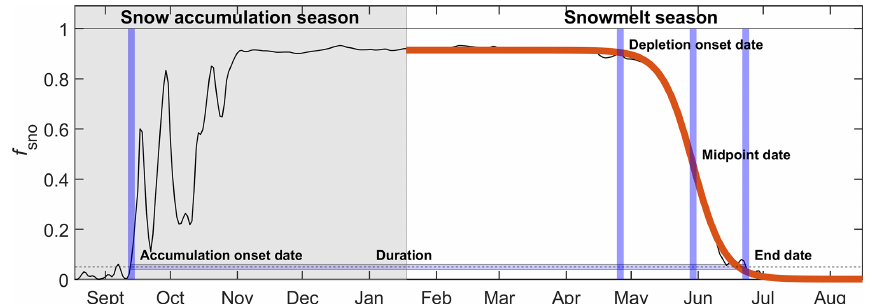
Figure 2. Time series of snow cover fraction ( f sno ) and sigmoid curve fitting at a typical pixel, represented by black and red lines, respectively. The blue lines indicate four phenology dates and one duration, and the shaded area shows the snow accumulation